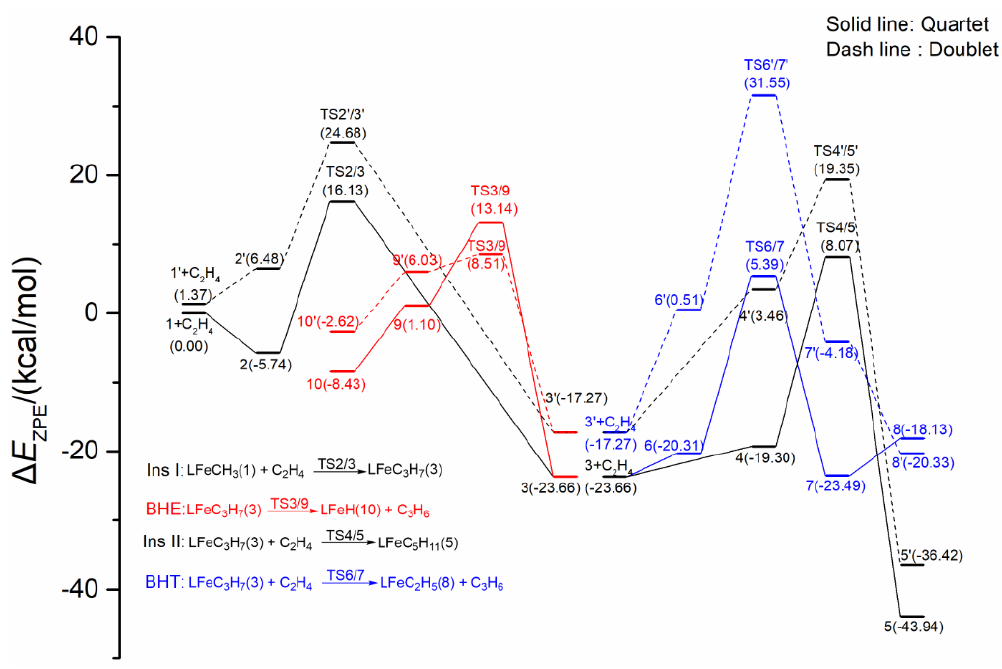
Figure 6. Energy profiles (kcal / mol) for the first and second ethylene coordination and insertion (black), β -H transfer ( BHT , in blue) and β -H elimination ( BHE , in red) catalyzed by the neutral iron complex in doublet (dash line) and quartet (solid line) spin states. The energies are relative zero-point energies with respect to the reactants: LFeCH 3 ( 1 , quartet state) and C 2 H 4 . The number n corresponds to Fe(0)- n , the TS m / n refers to the transition state between the two intermediates Fe(0)- m and Fe(0)- n .